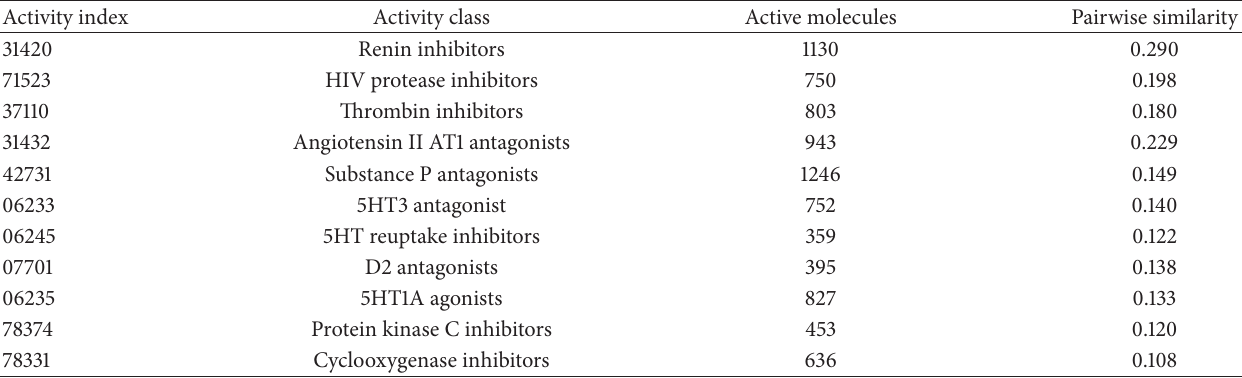
Table 1: MDDR activity classes for DS1 data set.